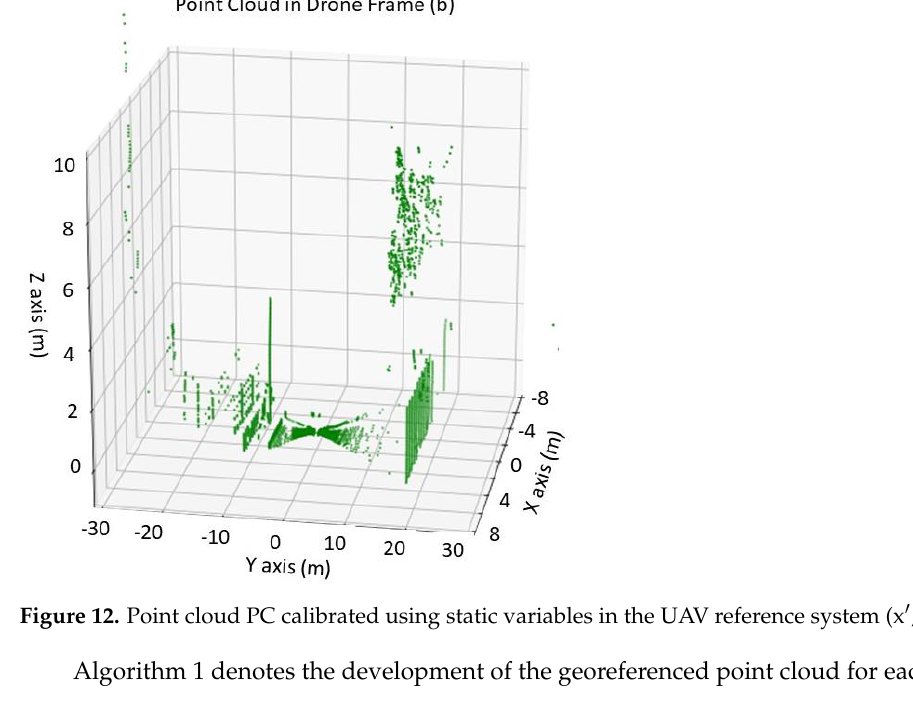
Algorithm 1 denotes the development of the georeferenced point cloud for each path. Algorithm 1: Generation of Georeferenced Point Cloud for Each Path